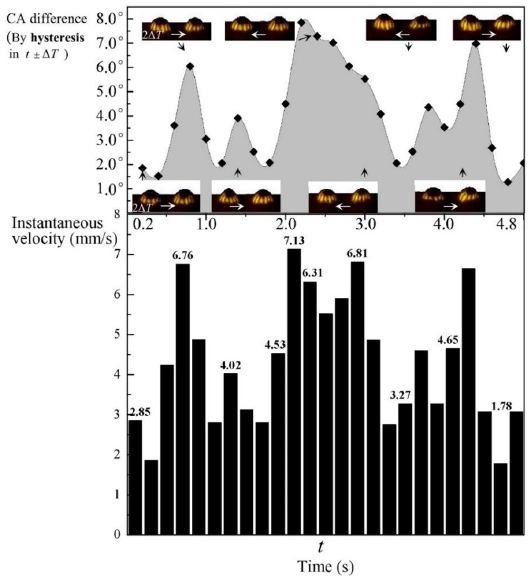
Figure 9. The level of CA hysteresis within a nearby interval Δ T of specific equilibrium wetting moments and the chart of instantaneous droplet velocity varying among wetting moments.